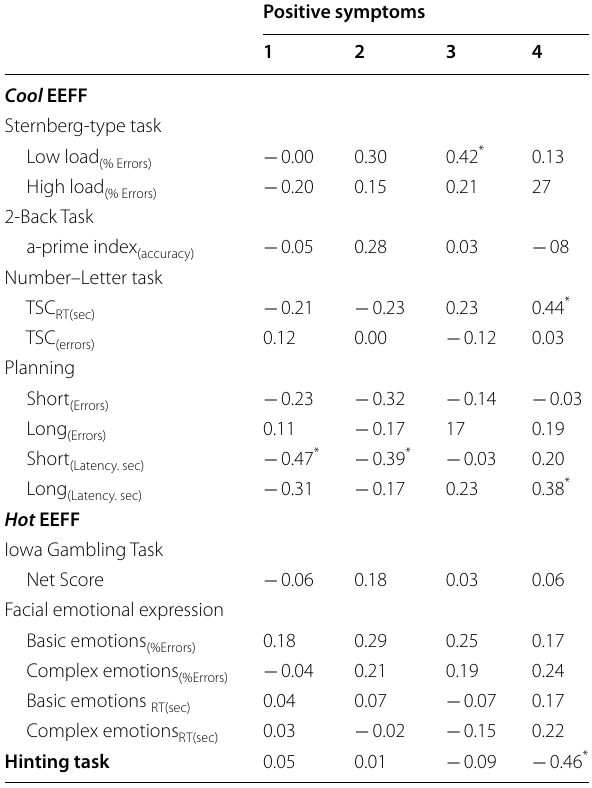
Table 5 Correlations coefficients ( r ) between positive symptoms and EEFF